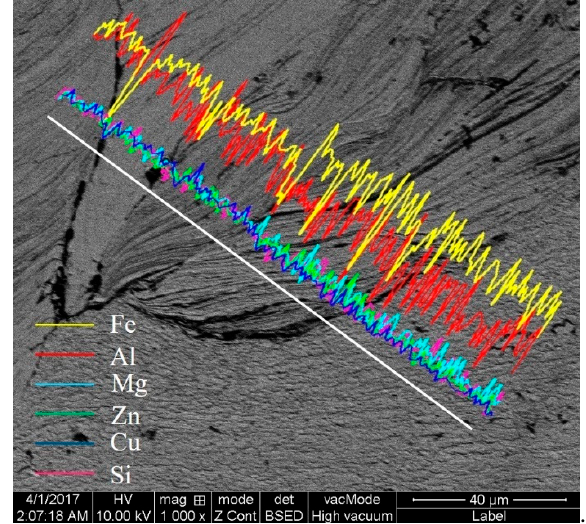
Figure 11. Micromorphology and EDS of the cloud cluster-like microstructure.